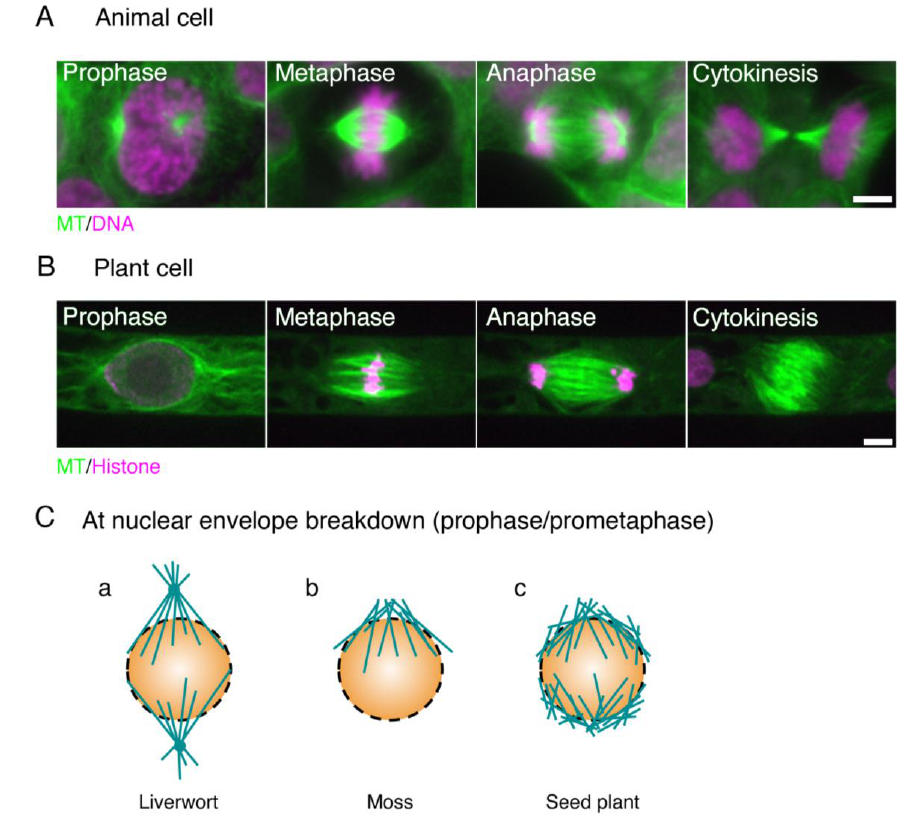
Figure 1. Animal and plant spindles. ( A ) Human HCT116 cells stained with anti-α-tubulin antibody (green) and DAPI (purple); ( B ) Spindles in the moss Physcomitrella. patens highlighted by GFP-tubulin (green) and histone H2B-RFP (purple). The two main differences between animal and plant spindles are (1) the presence of centrosomes and well-developed astral MTs in animal spindles, and (2) the morphology of the anaphase spindle (the ‘phragmoplast’ in plants). Bars, 5 µm; ( C ) distinct types of